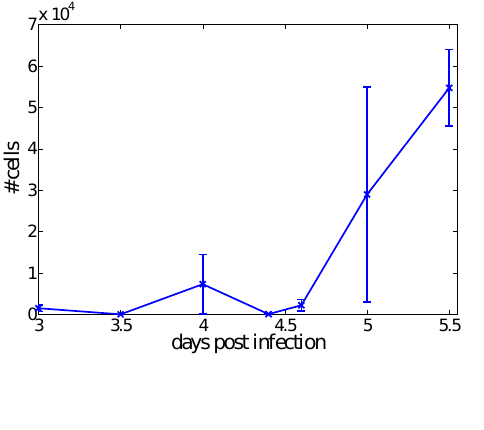
Figure 1. Experimental CD8 T-cell counts over time in mice lymph nodes. The data were collected following intranasal H1N1 infection in C57Bl/6 mice (adoptively transferred with F5 cells 24 h prior to the infection). The data used were from two independent experiments with different kinetics and two to four mice per time point. Error bars show the SEM and the average is marked in blue